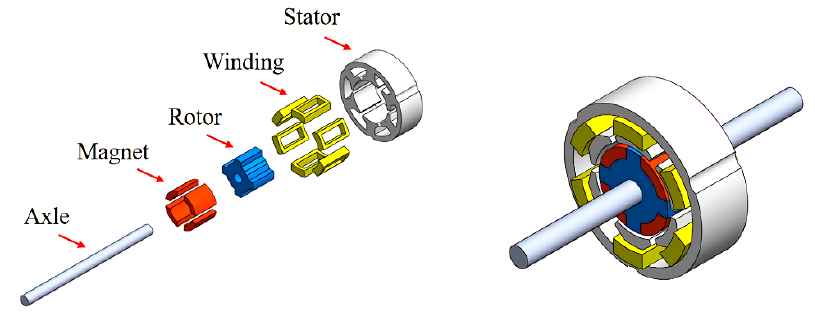
Figure 1. Exploded view and assembly drawing of the inset permanent magnet synchronous motor.